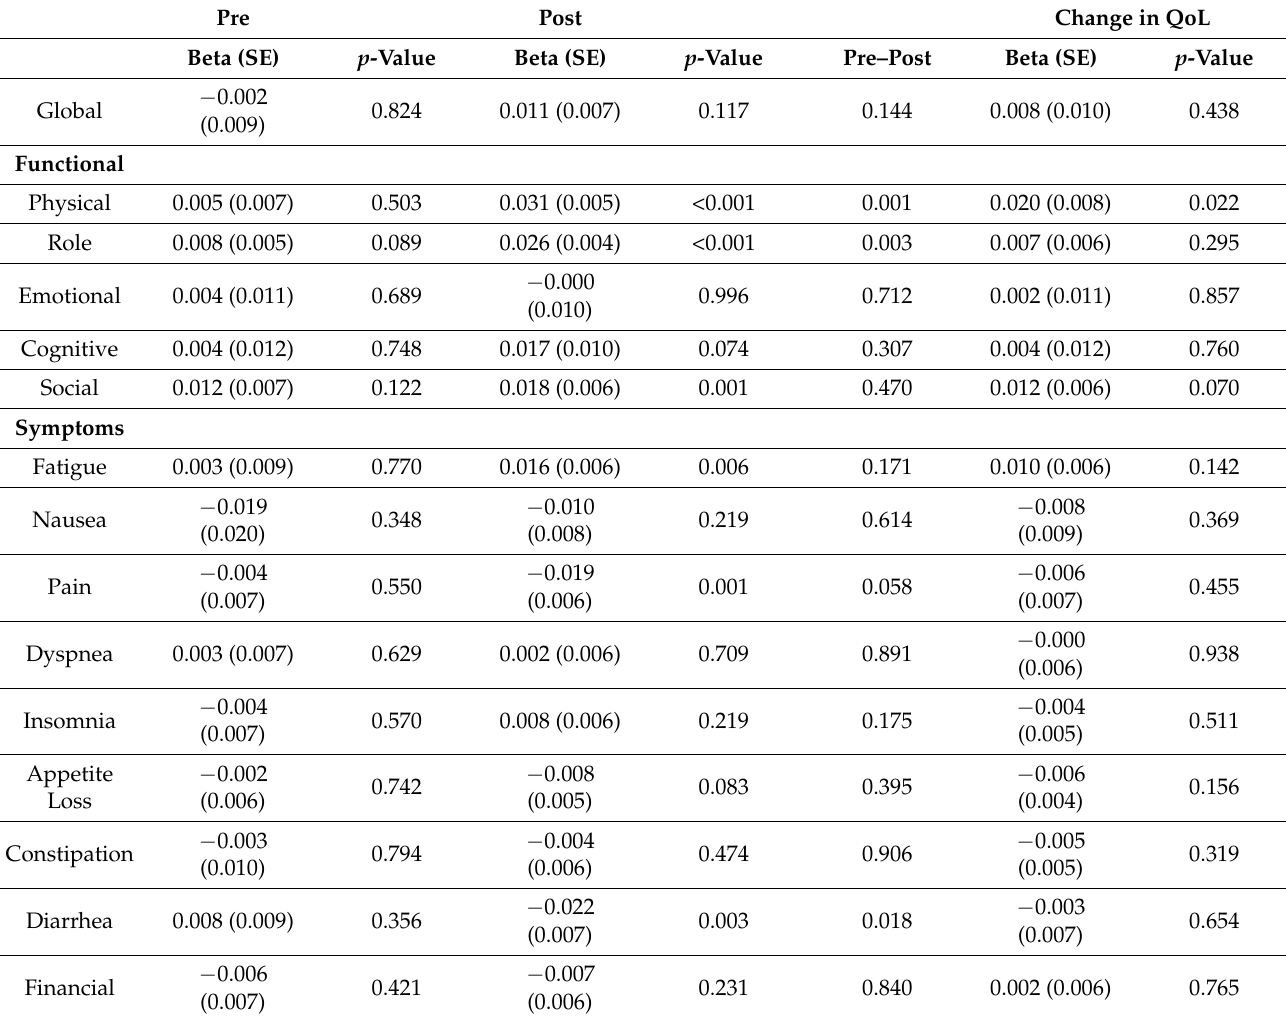
Table 4. Correlation between the SPPB and quality of life for the radiation